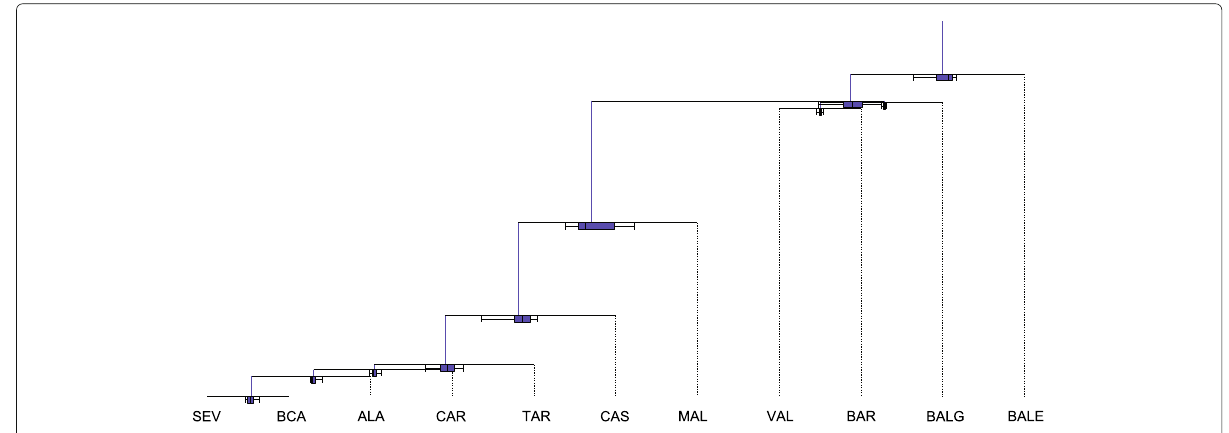
Fig. 9 Codadendrogram. SpanishMed balances of traffic composition following the selected SBP (Table